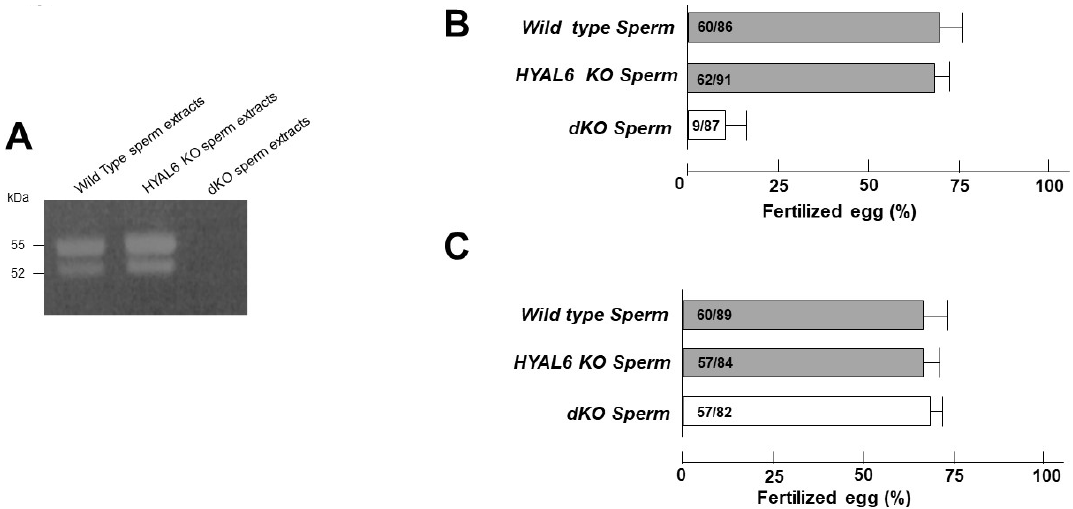
Figure 6. Zymography and in vitro fertilization assay. ( A ) Sperm protein fractions were prepared from wild-type mice, HYAL6 KO sperm, and HYAL5/HYAL7 double-KO (dKO) sperm; then, 30 µg of the sperm extracts were separated by 0.1% hyaluronan sodium dodecyl sulfate-polyacrylamide gel electrophoresis under non-reducing conditions and analyzed by zymography. ( B ) Fertilization ratio of intact eggs inseminated with capacitated cauda epididymal sperm from HYAL6 and dKO (open column). ( C ) Fertilization ratio was determined after inseminating cumulus-free eggs with capacitated cauda epididymal sperm derived from HYAL6 KO (shaded column) and dKO (open column) mice.